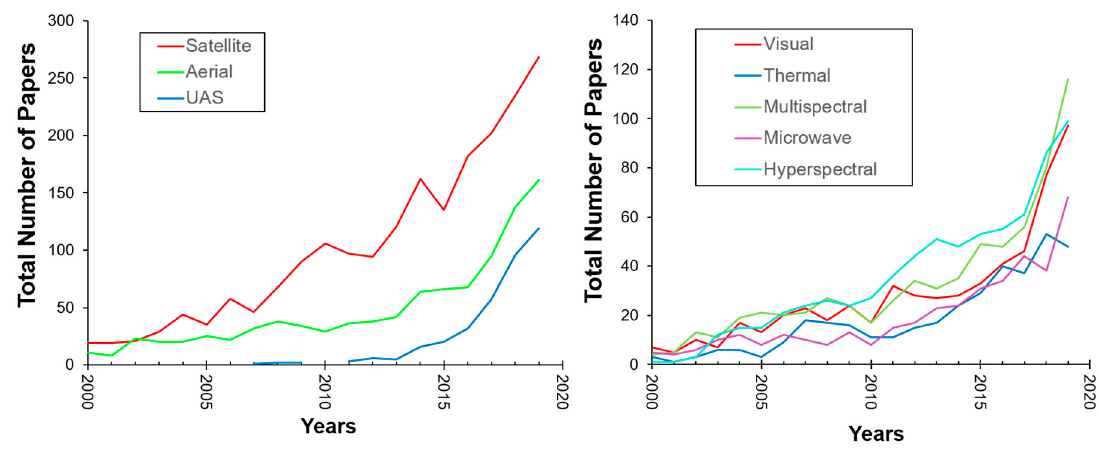
Figure 2. Number of studies focused on agricultural remote sensing between 2000 and 2019 by platform and sensor